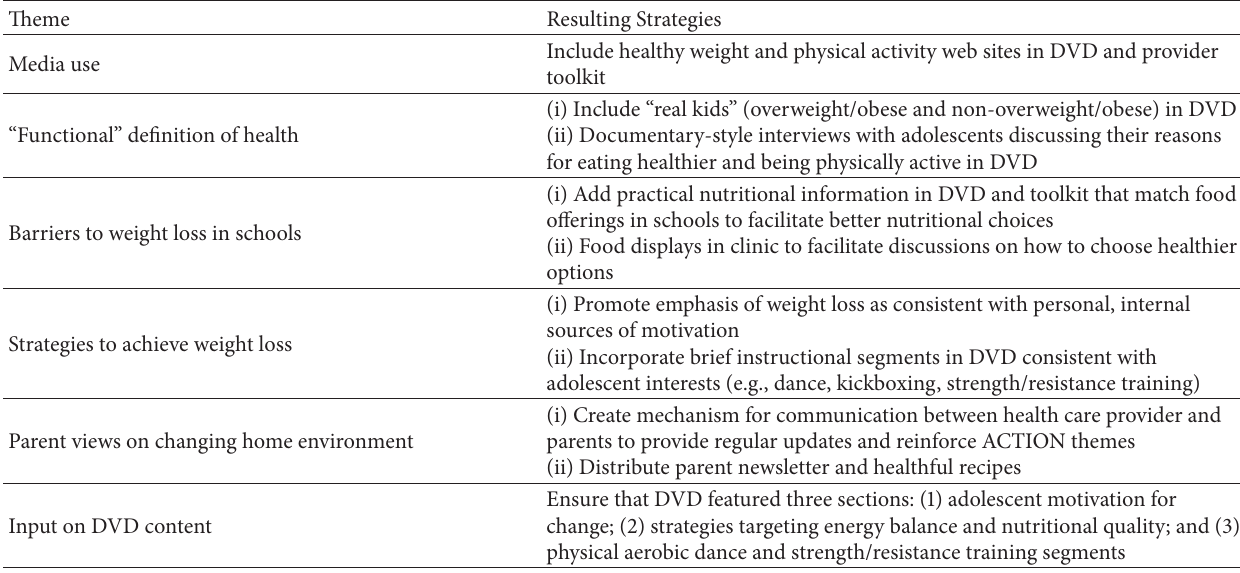
Table 3: Key informant themes and resulting intervention